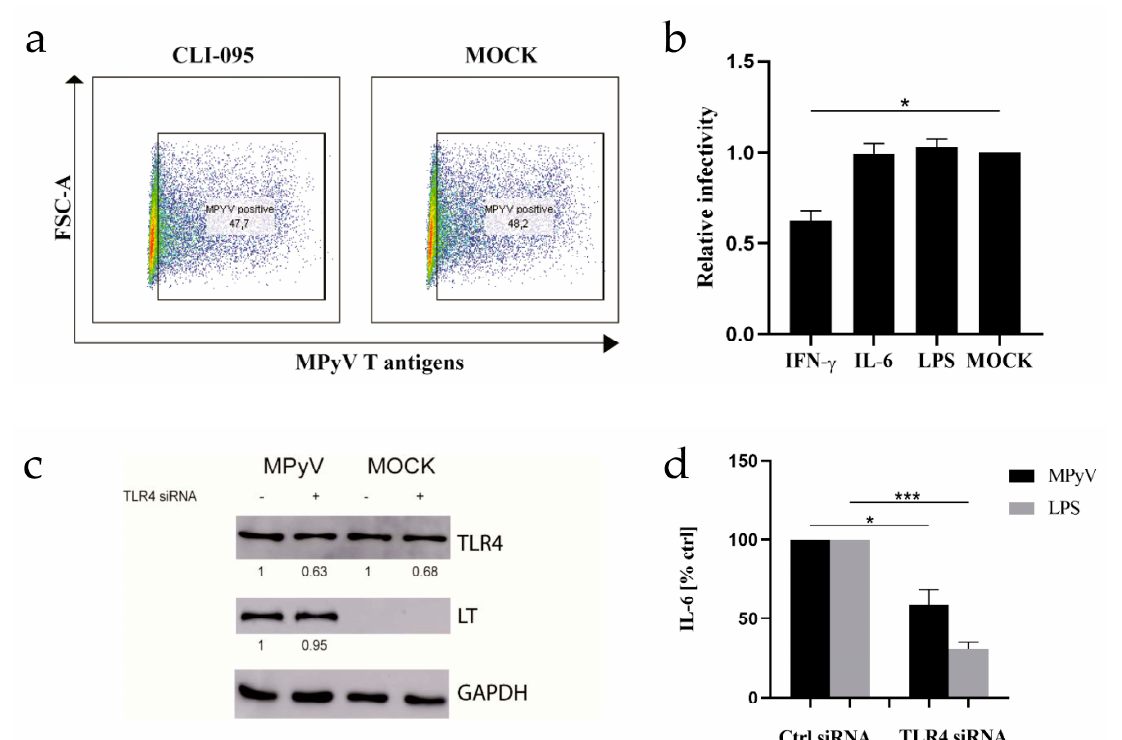
Figure 3. Effect of TLR4 signaling on MPyV lifecycle in MEFs. ( a ) Flow cytometry analysis of the percentage of MPyV- positive MEFs determined by expression of T antigens in the presence or absence (MOCK) of TRL4 inhibitor CLI-095 (10 µM) ( b ) Relative infectivity of MPyV in 3T6 cells pretreated with IFN- γ (100 IU/mL), IL-6 (10 ng/mL), LPS (10 µg/mL) or mock-treated (MOCK) determined by expression of T antigens. Relative infectivity was assessed by flow cytometry, and data were normalized to MOCK. ( c ) The effect of TLR4 silencing on TLR4 and LT levels in MPyV-infected MEFs was followed by Western blot. The values shown below each band represent the relative quantity of TLR4 or LT determined by densitometry normalized to the MOCK-infected MEFs treated with control siRNA. GAPDH was used as a loading control. ( d ) The effect of TLR4 silencing on the IL-6 production in MEFs infected with MPyV or stimulated with LPS measured by ELISA. * p < 0.05; ** p < 0.01; *** p < 0.001; two-tailed t -test.